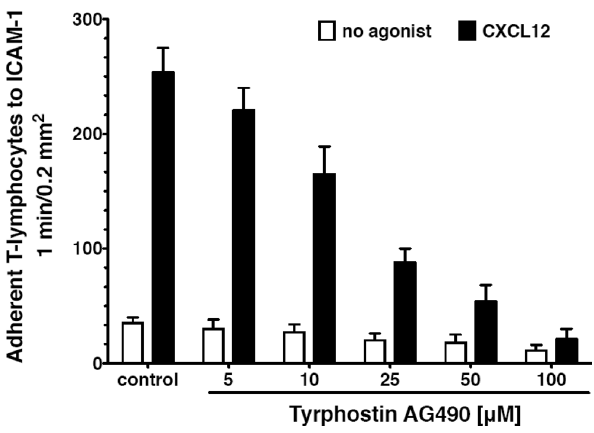
Figure 6. Effects of Jak2 inhibition. Lymphocytes were pre-treated with the indicated concentrations of tyrphostin AG490 at 37 u C for 15 min and stimulated with 200 nM CXCL12 for 1 min. Plots are averaged values of adherent cells = 0 : 2 mm 2 with standard deviation N=5.